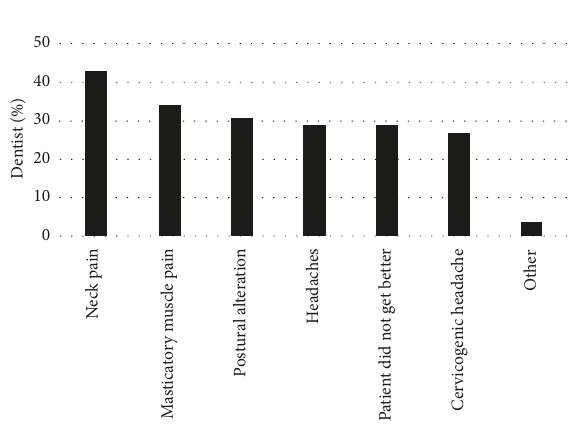
Figure 2: Conditions under which TMD patients are referred to physical